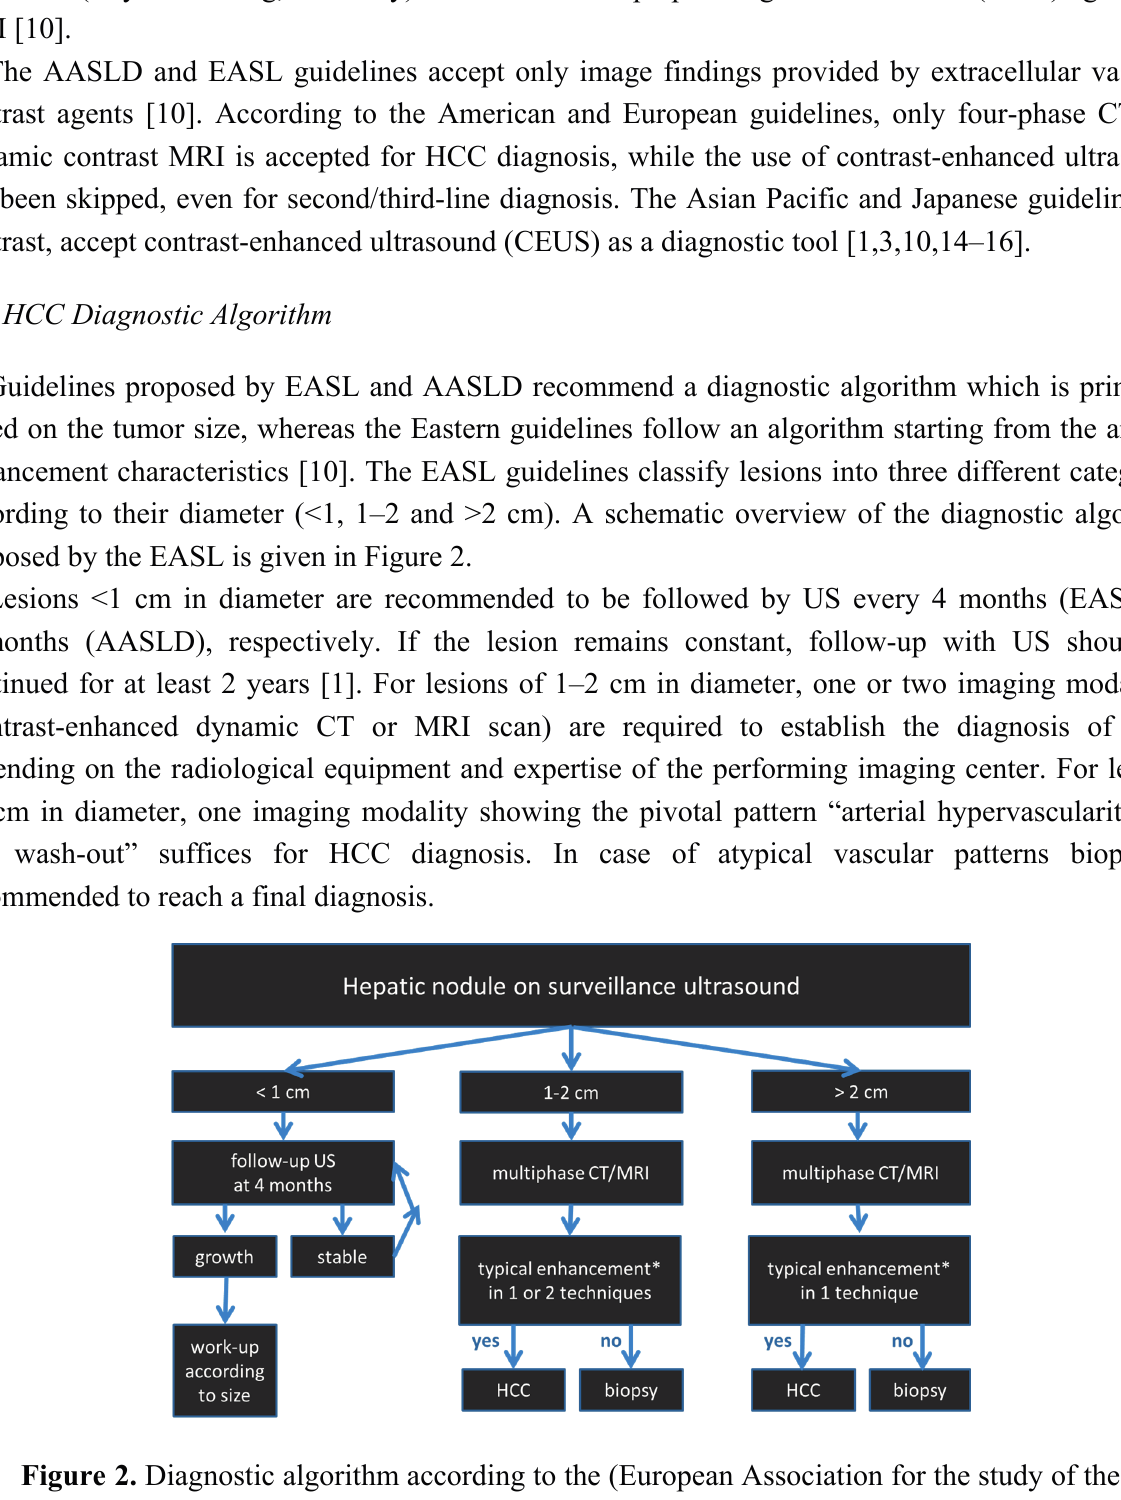
Figure 2. Diagnostic algorithm according to the (European Association for the study of the liver (EASLD) for the evaluation of hepatic nodules in patients at risk for HCC. * typical enhancement: arterial hyperenhancement, portal venous/late phase